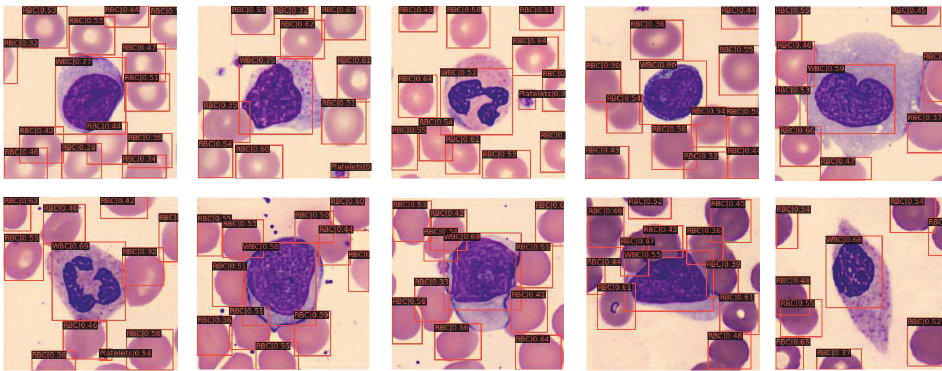
Figure 5. Visualization detection results on WID